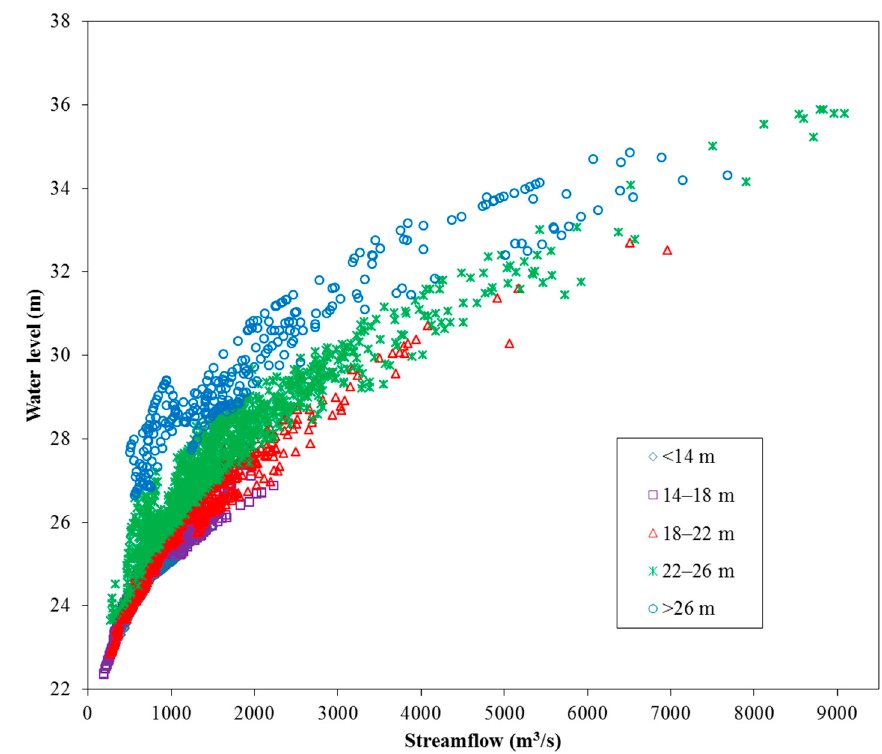
Figure 10. Stage-discharge relationship at the Xiantao Hydrological station under different water level of the Yangtze River.